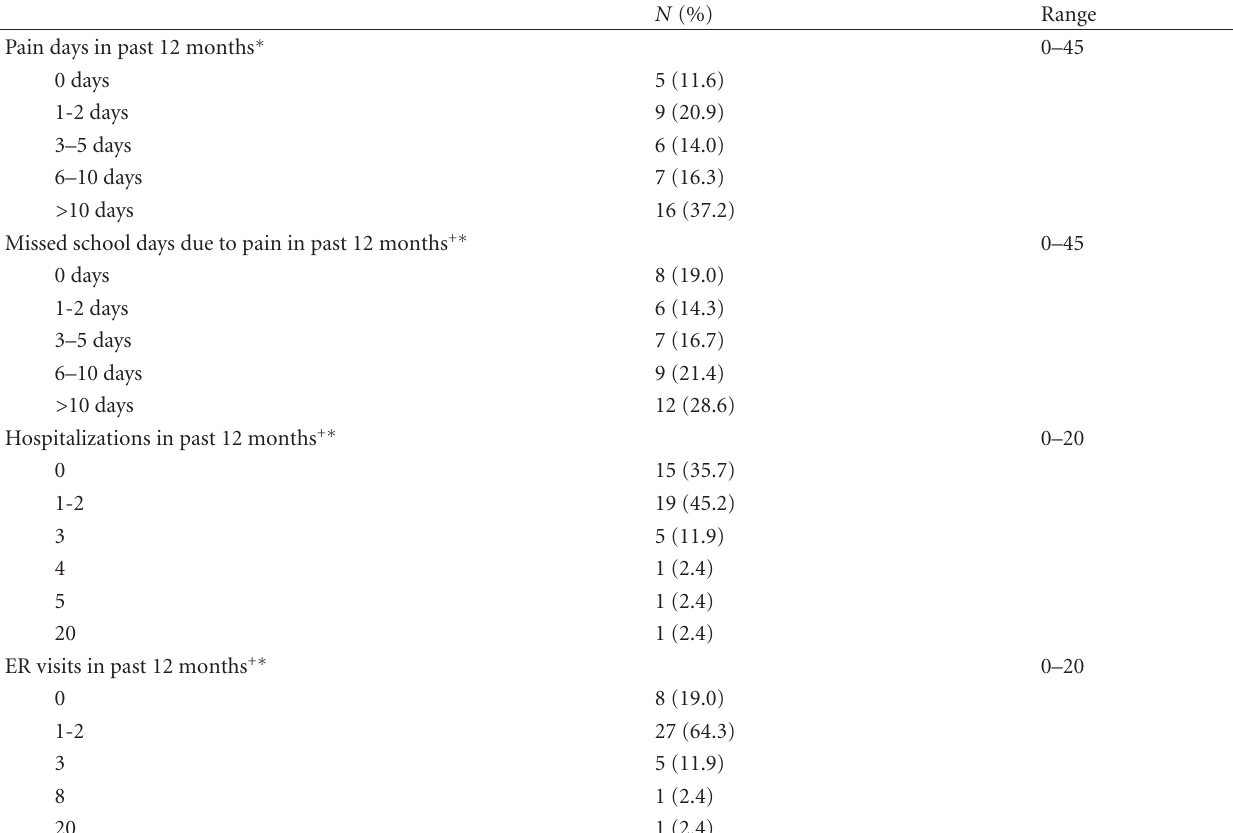
Table 2: Patient clinical